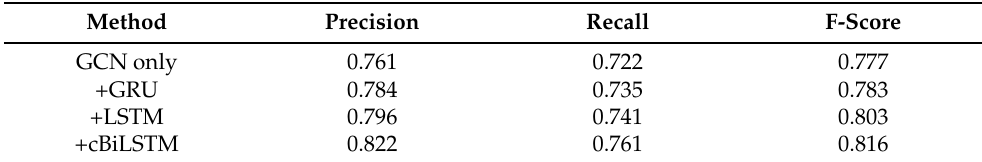
Table 4. Ablation study on different contextual representation methods.